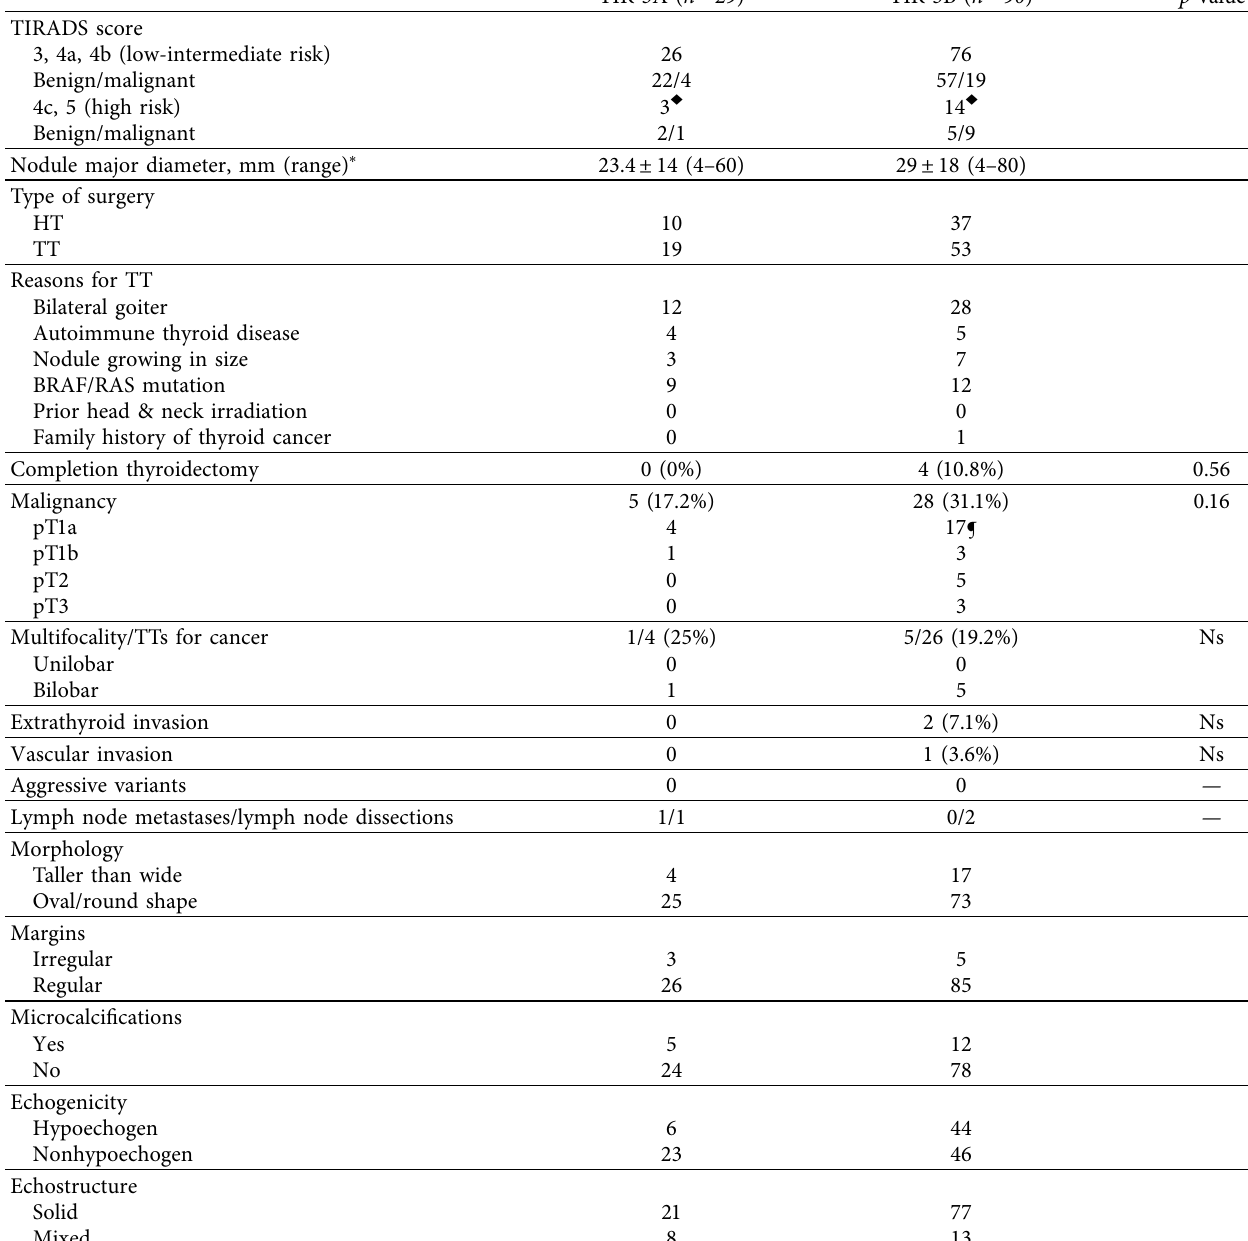
Table 2: Surgical treatment, demographic, and pathologic